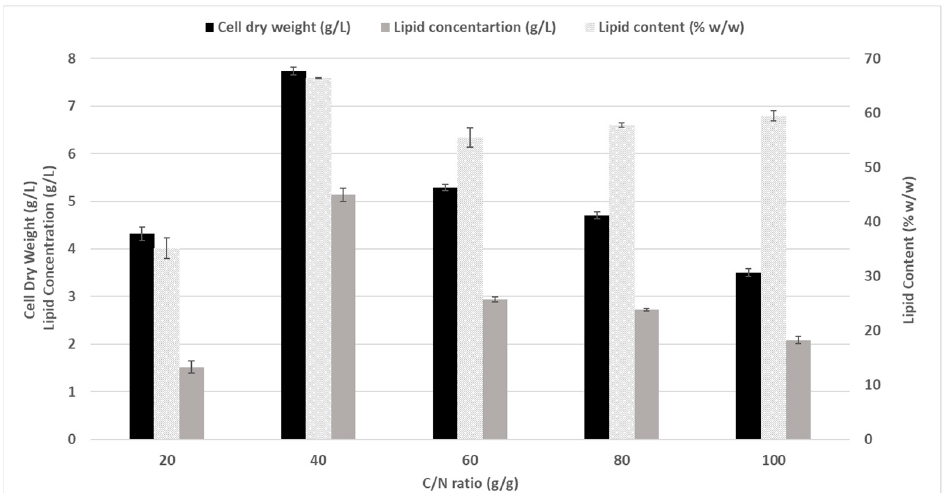
Figure 1. Growth and lipid accumulation of Pseudanabaena sp. at different C/N ratios. The effect of C/N ratios on cell dry weight (g/L), lipid content (% w / w ), and total lipid concentration (g/L) is shown after 120 h of culture. All measurements were performed in triplicate; error bars denote the standard deviation.